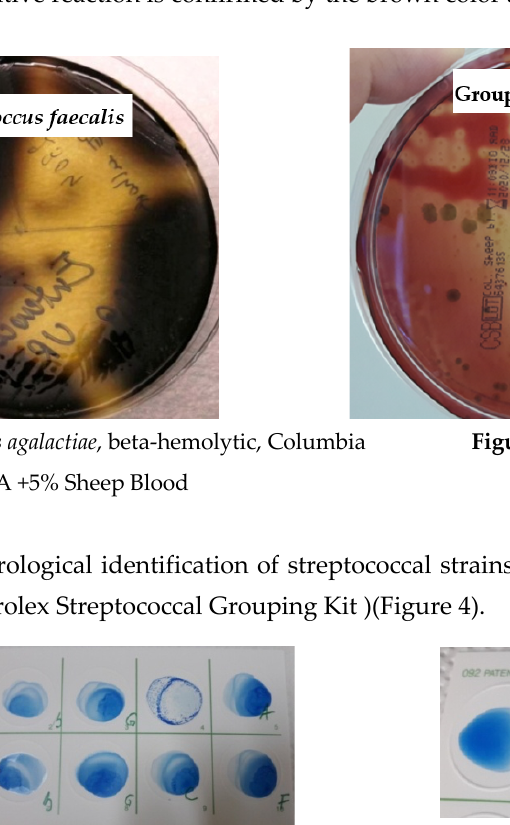
Figure 4 . Group confirmatory serology Streptococcus agalactiae ( gr.B), Enterococcus faecalis (